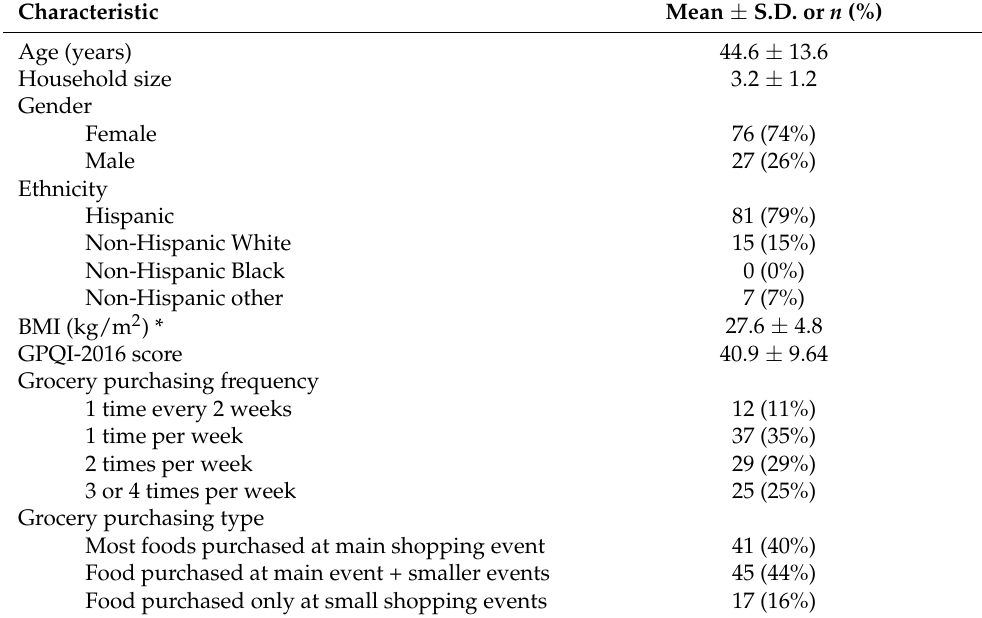
Table 1. Socio-demographic characteristics and grocery purchasing behaviors of the sample ( n =